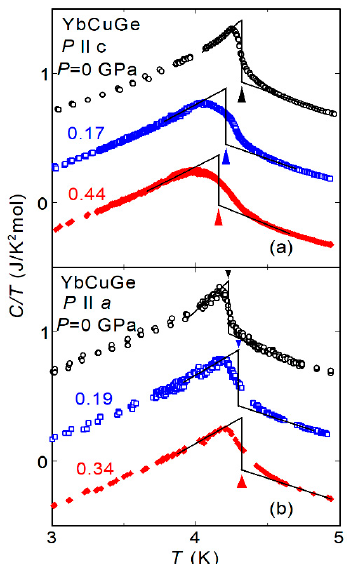
Figure 4. Temperature dependence of the specific heat divided by temperature C/T of YbCuGe under uniaxial pressures applied along the c axis ( a ) and a axis ( b ). The arrows indicate the antiferromagnetic ordering temperature T N . The data sets at various pressures are shifted downward by 0.5 J/K 2 mol for